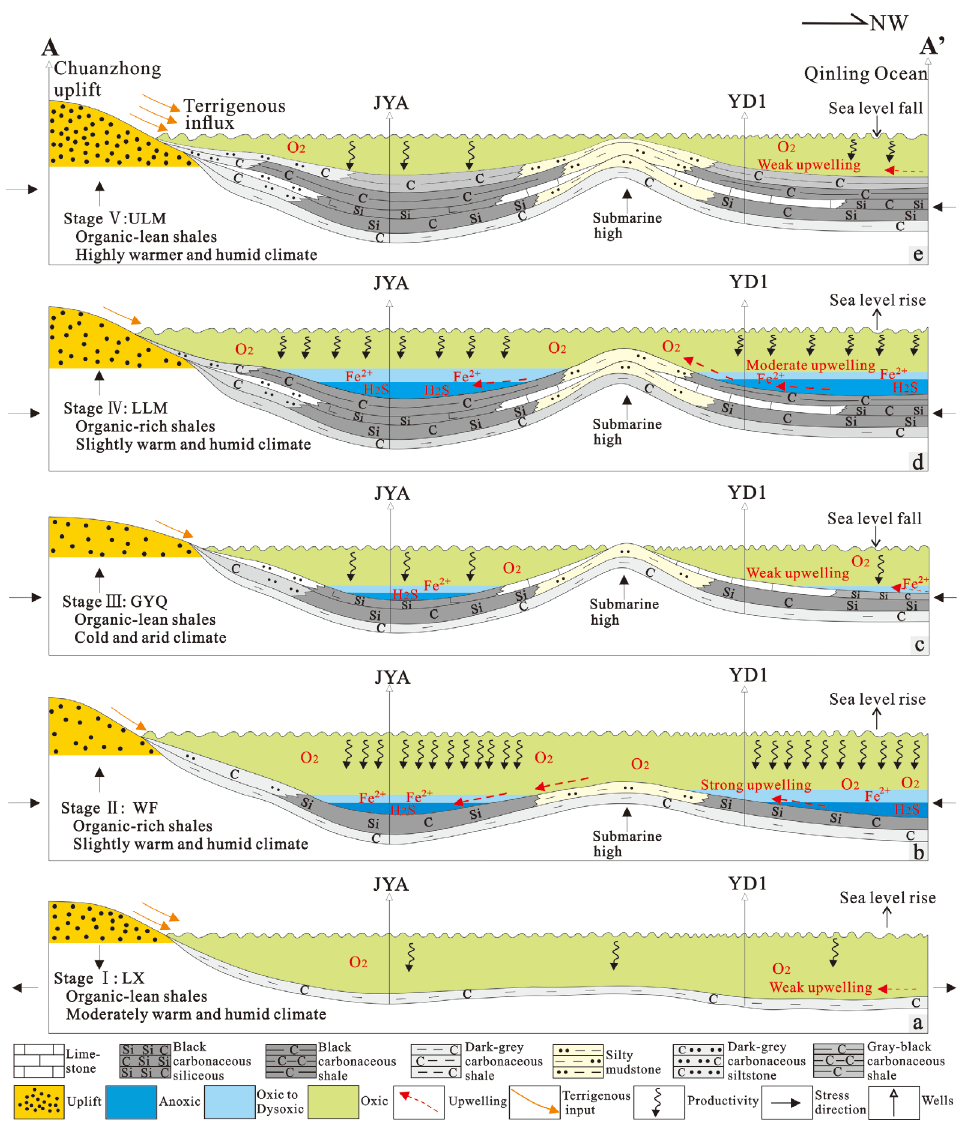
Figure 14. The model of the palaeoenvironmental evolution of the Wufeng – Longmaxi Formation in well YD1. ( a ) The palaeoenvironmental conditions in the LX stage showing moderate terrigenous influx, moderately warm and humid climate, oxic conditions and low productivity. ( b ) The palaeoenvironmental conditions in the WF stage showing low terrigenous influx, slightly warm and humid climate, ferruginous anoxic conditions conditions and high productivity. ( c ) The palaeoenvi- ronmental conditions in the GYQ stage showing low terrigenous influx, cold and arid climate, oxic conditions and low productivity. ( d ) The palaeoenvironmental conditions in the LLM stage showing low terrigenous influx, slightly warm and humid climate, ferruginous to euxinic anoxic conditions conditions and moderate to high productivity. Remarkably, euxinic conditions in the lower LLM are mainly attributed to the rise in sea level caused by the melting of Gondwanan continental glaci- ers and strong tectonic subsidence caused by continuous compression from the Xuefeng uplift to the Yangtze Platform [16], leading to the formation a deep - water basin. ( e ) The palaeoenvironmental conditions in the ULM stage showing high terrigenous influx caused by the Kwangsian Orogeny , highly warm and humid climate, oxic conditions and low productivity.